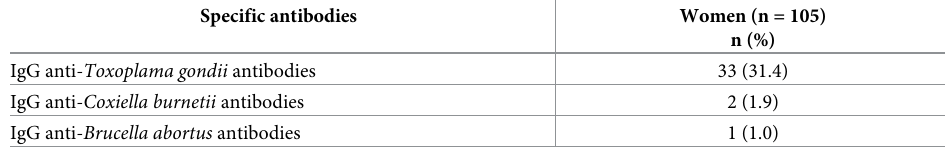
Table 3. Seropositivities for IgG anti- Brucella abortus , Coxiella burnetii , and Toxoplasma gondii antibodies.